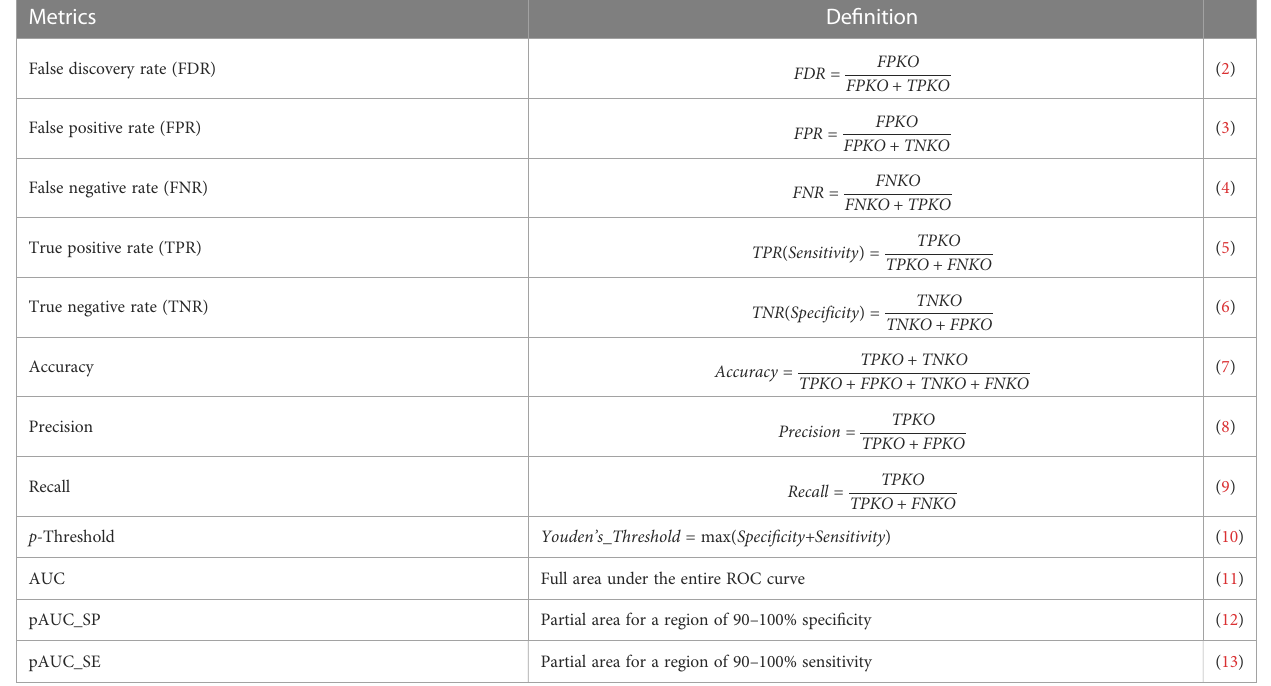
Table 1 Key metrics used for the ROC curve-based statistics analysis.